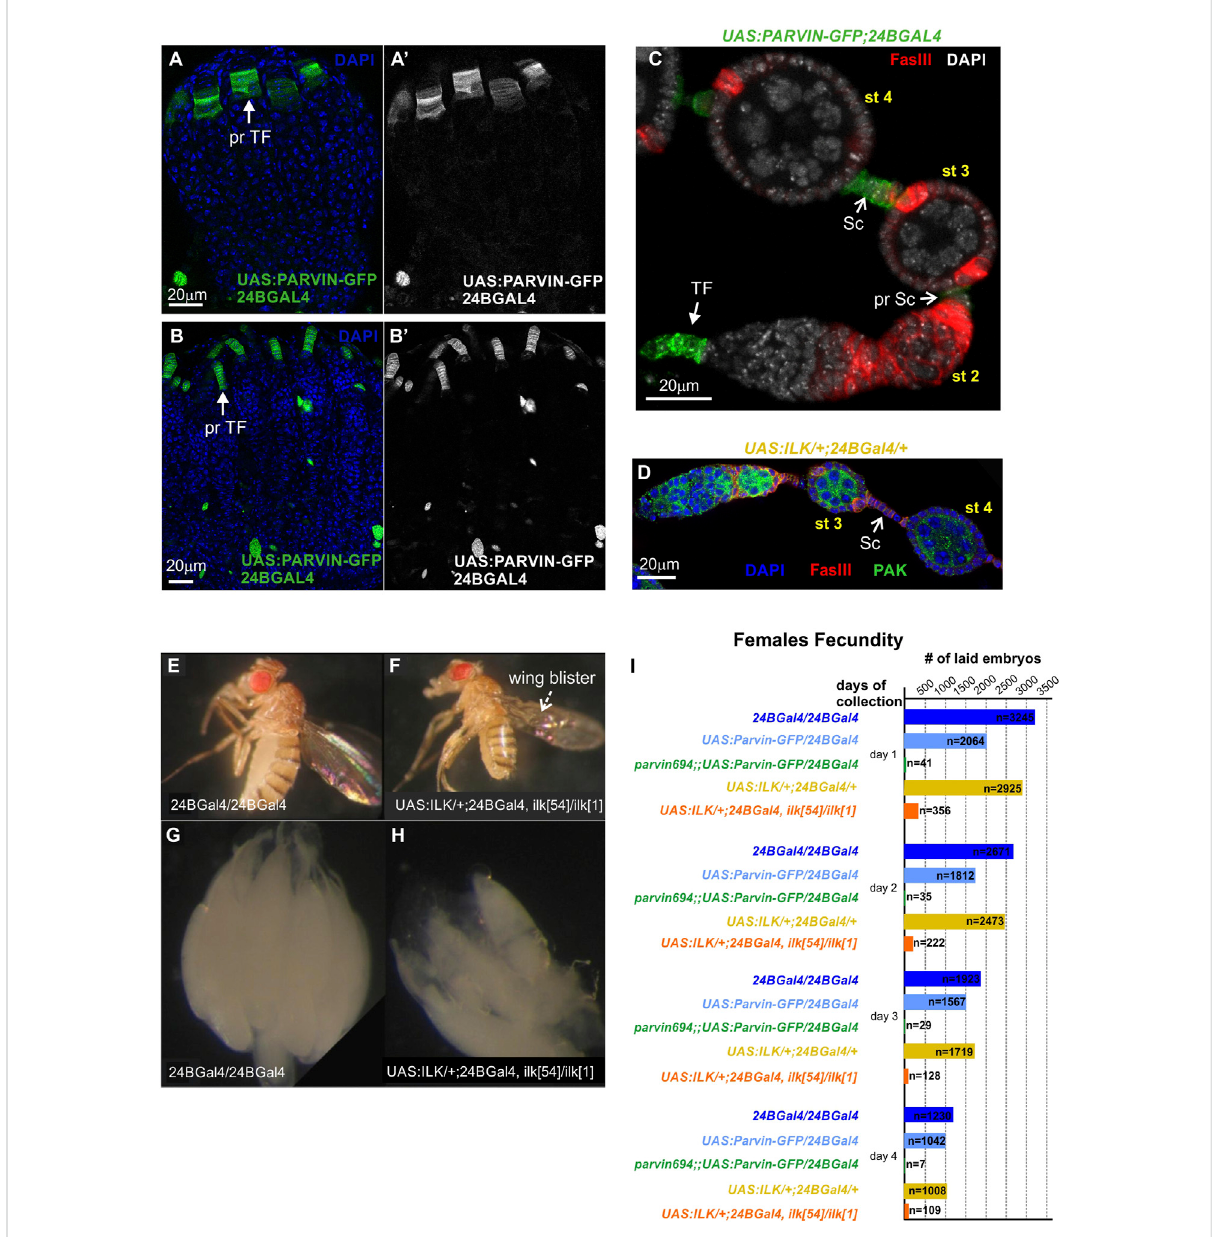
FIGURE 5 Parvin and ILK are required for female fecundity. (A-B 9 ) Ovaries from (A) early pupal stage and (B) pharate adult. 24BGal4 is expressed in the precursors of terminal fi lament cells in the (A-A 9 ) early pupal stage and (B-B 9 ) pharate adult. (C,D) 24BGal4 expression pattern in adult ovary. 24BGal4 -mediatedexpressionof (C) Parvin-GFPand (D) ILK,interminal fi lamentcells,inpre-stalkandinfullydifferentiatedstalkcellsdoesnotaffect the structure and morphology of the developing ovariole. (E) 24BGal4 adult fl y and (F) 24BGal4 -rescued Ilk mutant adult fl y with wing blisters due to lack of 24BGal4 expression in the wing epithelium. (G – H) Ovaries from (G) 24BGal4 adult fl y, (H) 24BGal4 -rescued Ilk mutant adult fl y. The laterappears smaller in size and contains adecreased number of mature egg chambers. Each imageis representative ofat leasttendifferentimaged adult fl ies, fi ve different imaged ovaries or fi ve different imaged ovarioles of the same genotype and markers used. (I) Graphic illustration of the obtainedresultsinthefemalefecundityassay.The 24BGal4 -mediatedrescuedadult fl iesforeither Parvin or Ilk nullalleleslaidasigni fi cantlyreduced number of embryos compared to controls ( fl ies homozygous for 24BGal4, or expressing a single copy of UAS:Parvin-GFP and 24BGal4 , or expressing a single copy of UAS:ILK and 24BGal4 respectively). pr TF, precursors of terminal fi lament; TF, terminal fi lament; pr Sc, pre-stalk cells; Sc, stalk cells. Scale bars: 20 μ m in all